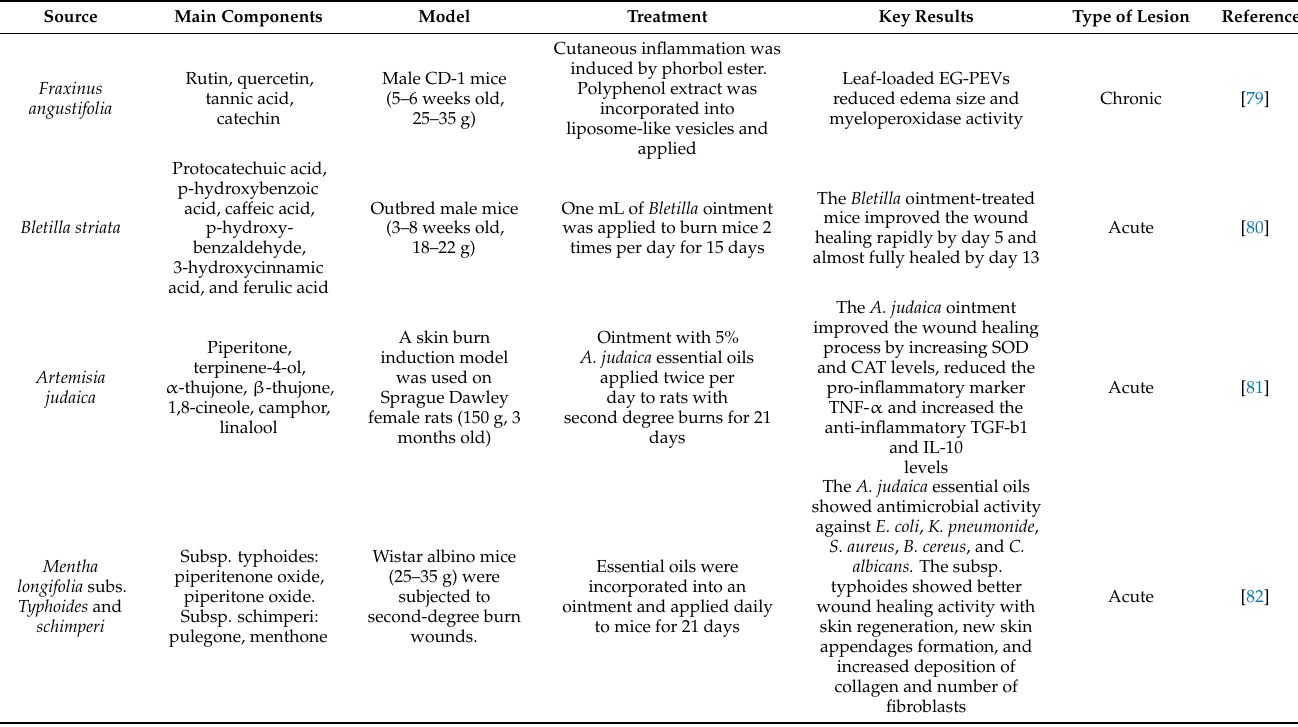
Table 2. In vivo studies of the wound healing properties of the natural